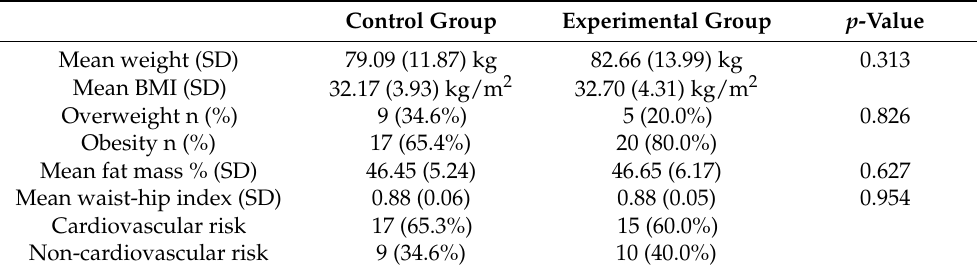
Table 2. Nutritional status of the total simple at baseline. SD, standard